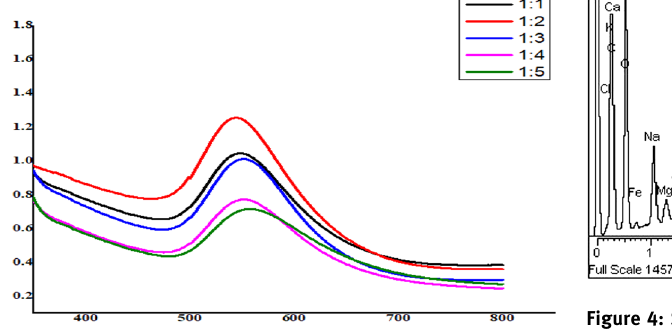
Figure 2: UV - Vis spectra of shoot extract ( SE )- mediated AuNPs.